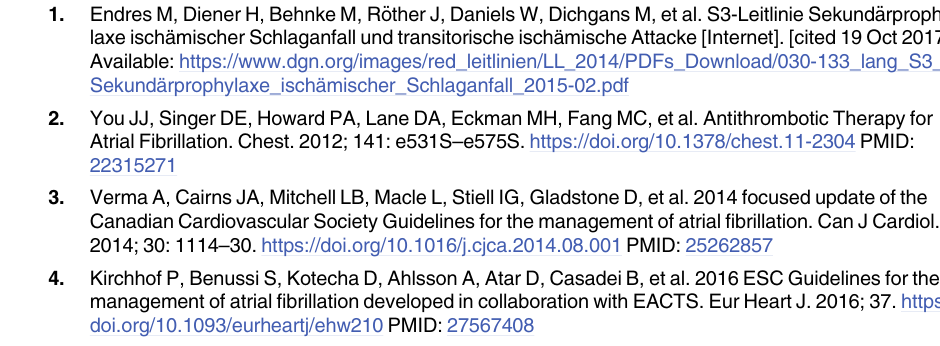
S1 Table. Extracted data of included studies. Extracted items are shown. S2 Table. Bias assessment tool. For each study, the risk of bias was thoroughly assessed at the study level using a modified National Heart, Lung, and Blood Institute (NHLBI) bias tool rec- ommended for non-randomized observational studies. S3 Table. Pooled characteristics of patients suffering acute cerebral ischemic events according to study quality. Data is presented of all included patiens suffering acute cerebral ischemic events while taking non-vitamin K oral anticoagulants (N = 12247) and only consid- ering studies of at least moderate quality (n = 10840). S4 Table. Prisma checklist. Checklist of systematic reviews according to the PRISMA guide-